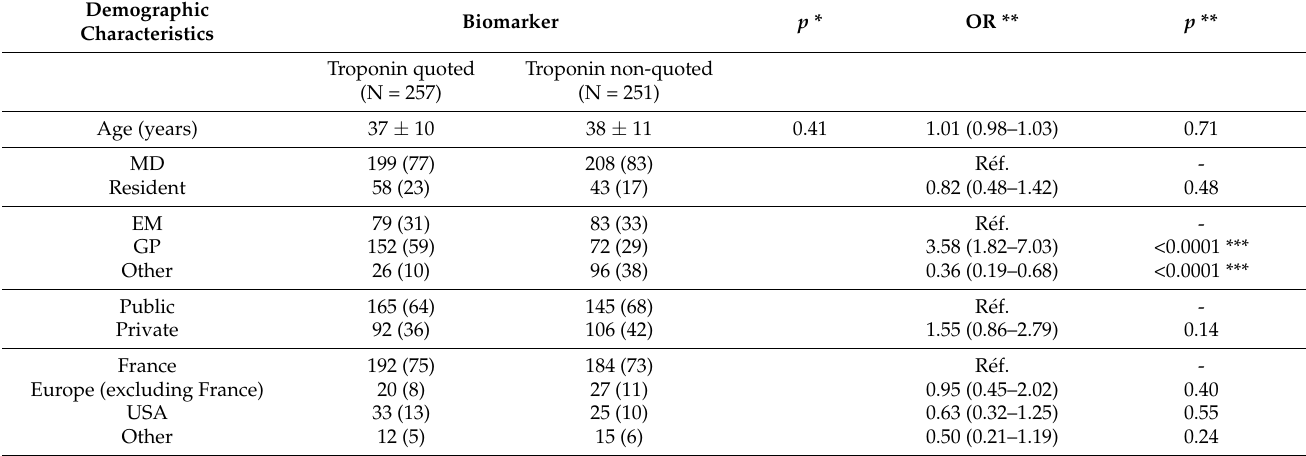
Table 3. Cardiac biomarkers and demographic